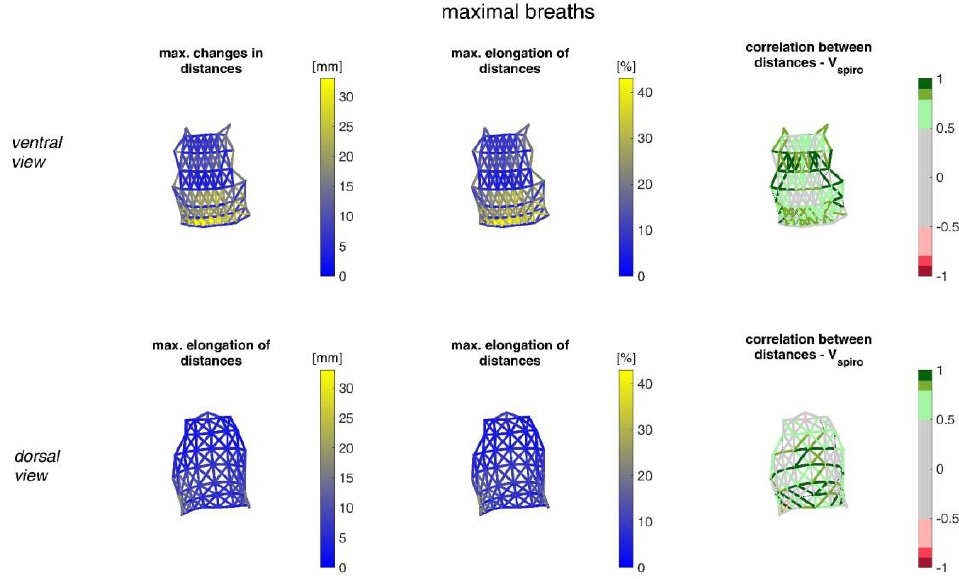
Figure 14. Illustration of the distance changes and elongations between MoCap markers at the upper body. The largest distance changes amongst all subjects during maximal breaths (left), the maximal distance elongation (center), and the mean corresponding correlation of maximal distances with V spiro of all subjects during maximal breaths are shown (right). (Top - ventral view, bottom - dorsal view). The dotted lines are the distances, which do not fulfil the requirement ( p < 0.05).